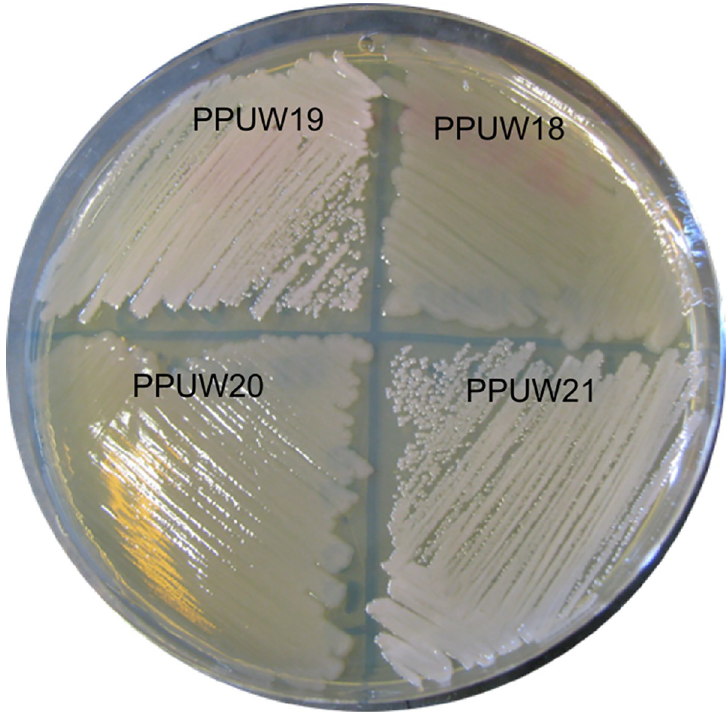
Fig 6. Phenotype of strains on LB supplemented with sodium octanoate. A milky white color was observed for PPUW19 ( phaC mutant harboring pTAM) and PPUW 21 (wild-type strain harboring pTAM). Yellowish color was observed for PPUW18 ( phaC mutant harboring pTH1227) and PPUW20 (wild-type strain harboring pTH1227).